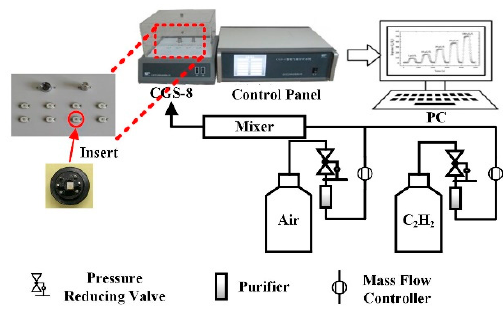
Figure 2. Gas sensing test system.